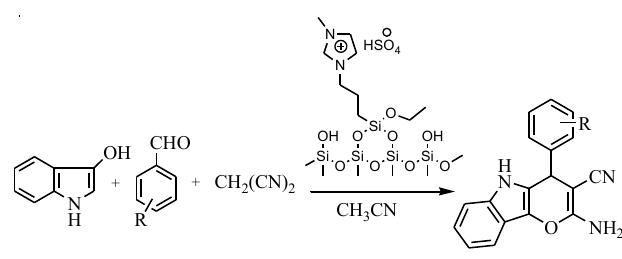
Figure 1. Synthesis of pyrano[3,2- b ]indole derivatives